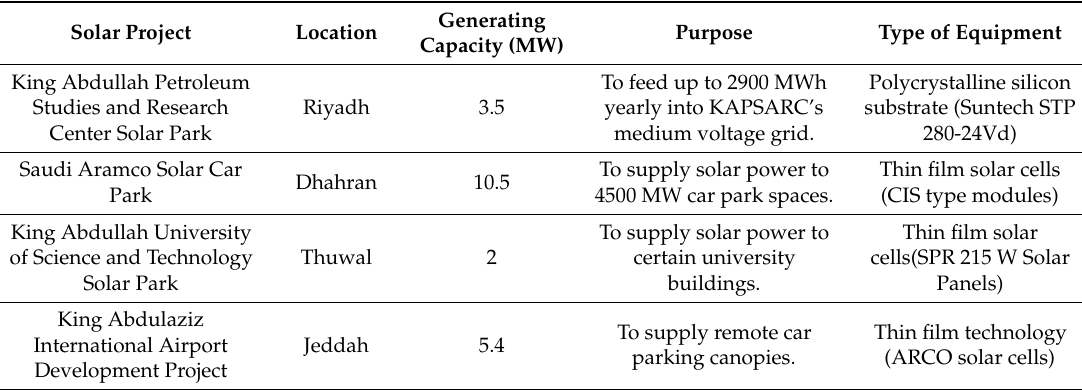
Figure 6. Solar PV projects in KSA: ( a ) King Abdullah Petroleum Studies and Research Center Solar Park; ( b ) Saudi Aramco solar car park, and ( c ) King Abdullah University of Science and Technology Solar Park. Adapted from [60]. Table 5. Selected solar projects in KSA. Adapted from